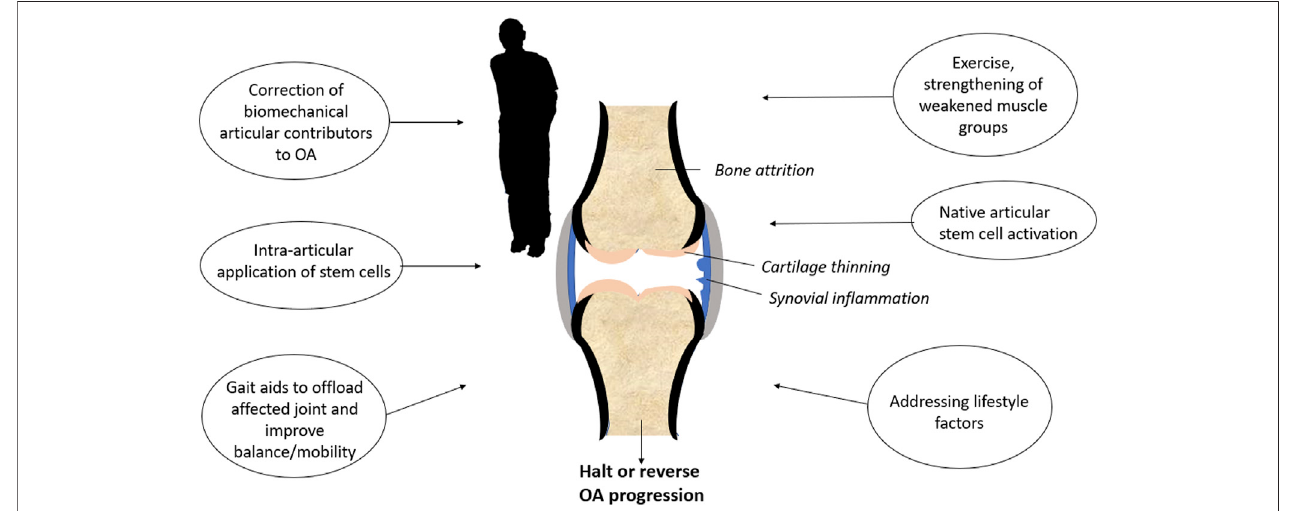
FIGURE 3 | Multimodal treatment of the osteoarthritis-affected